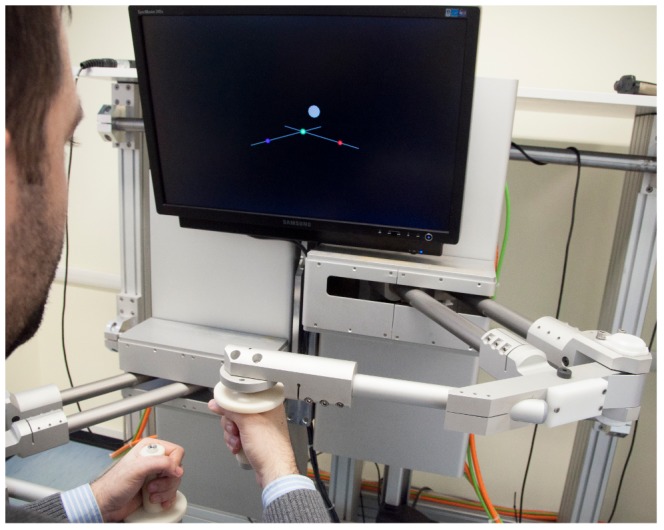
Experimental setup.The subject sits in front of the screen grasping the handles of the bimanual robot with the hands. The screen provides the visual feedback in the following way: the green ball represents the virtual mass, the blue ball the left hand, the red ball the right hand, the gray circle the target position and the two white sticks the virtual springs.